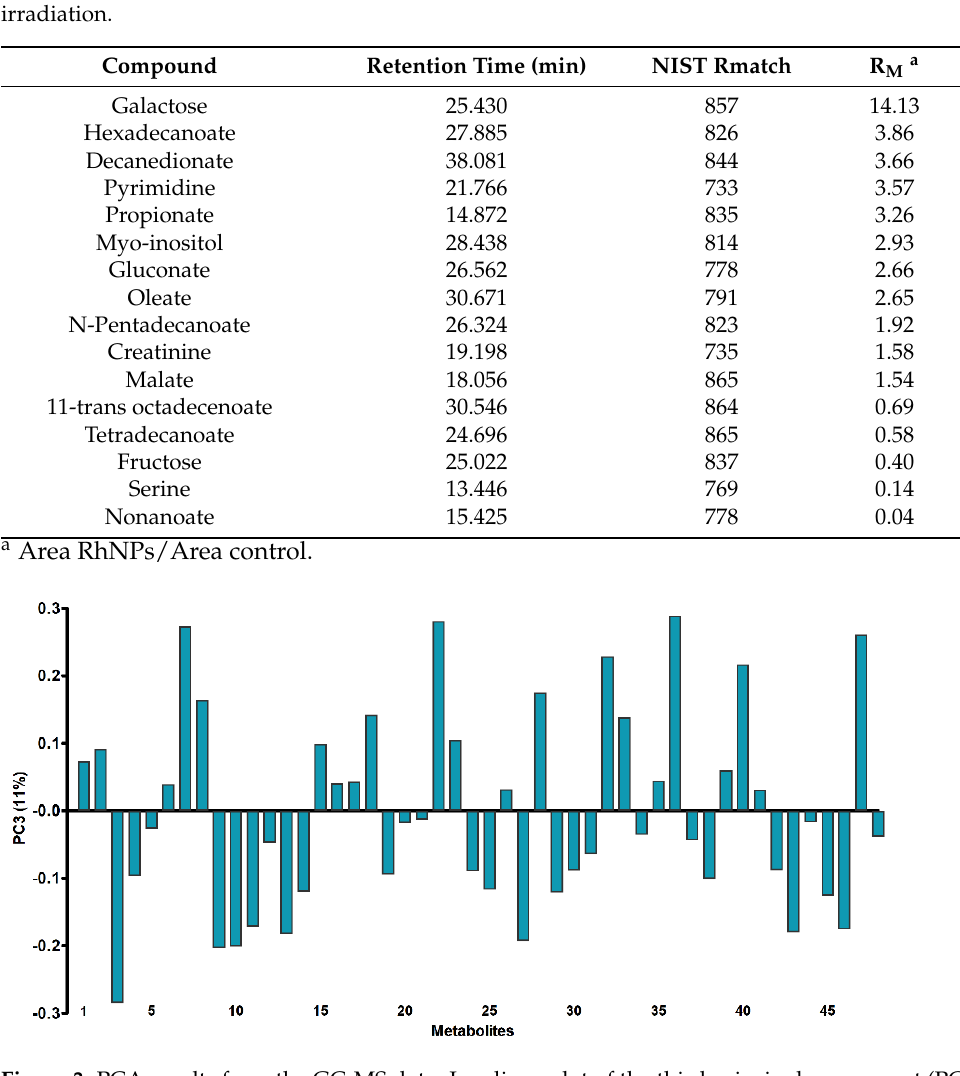
Table 2. Significantly altered metabolites ( p -values < 0.05) in HeLa cells treated with RhNPs and NIR